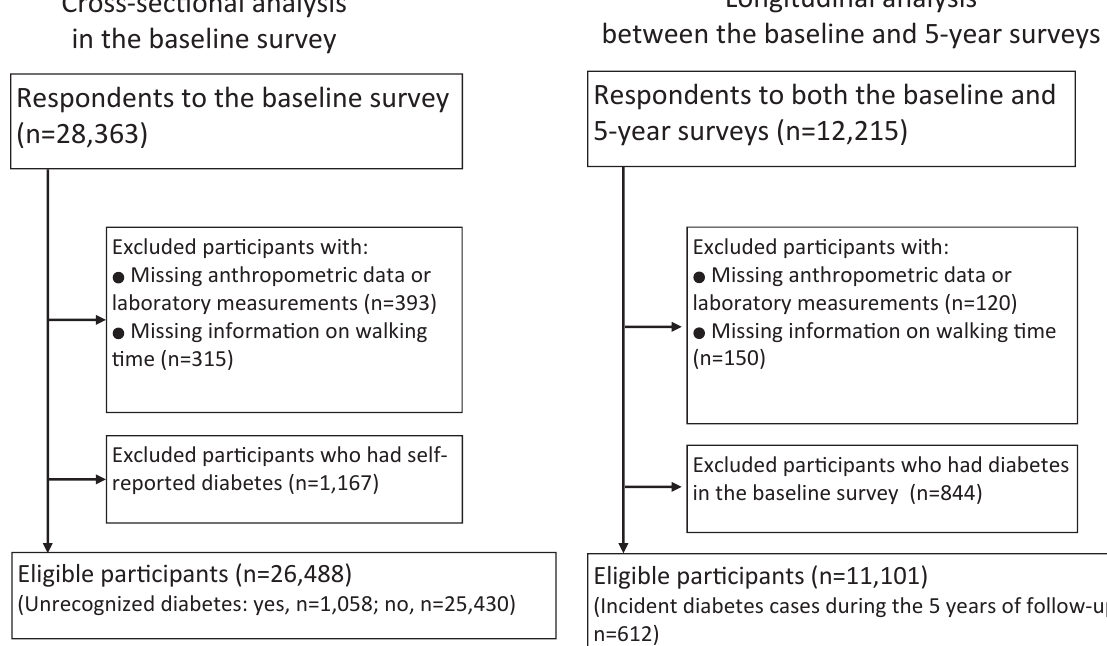
Figure. Flow chart of the study